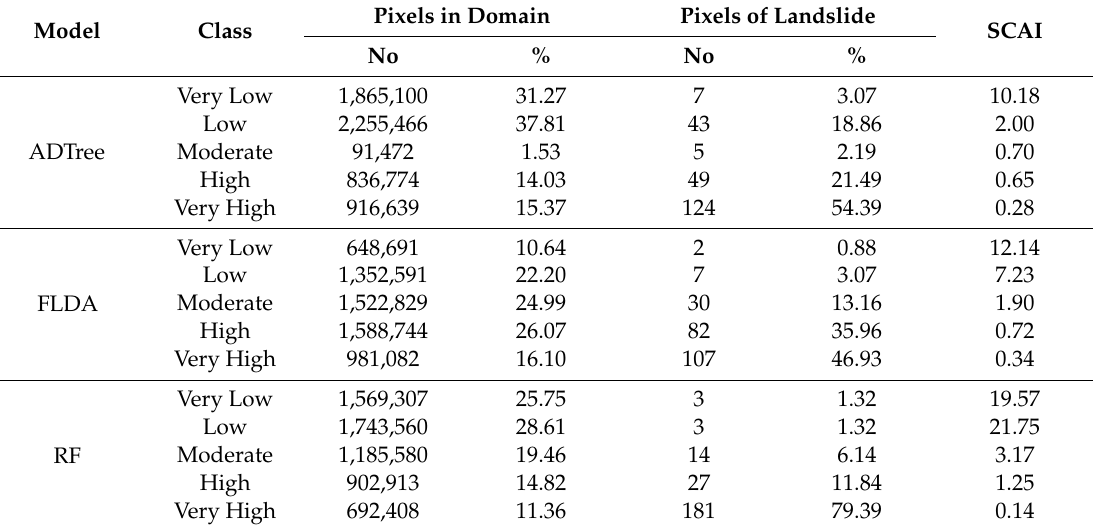
Table 4. Percentage of each susceptibility class along with SCAI values. Model